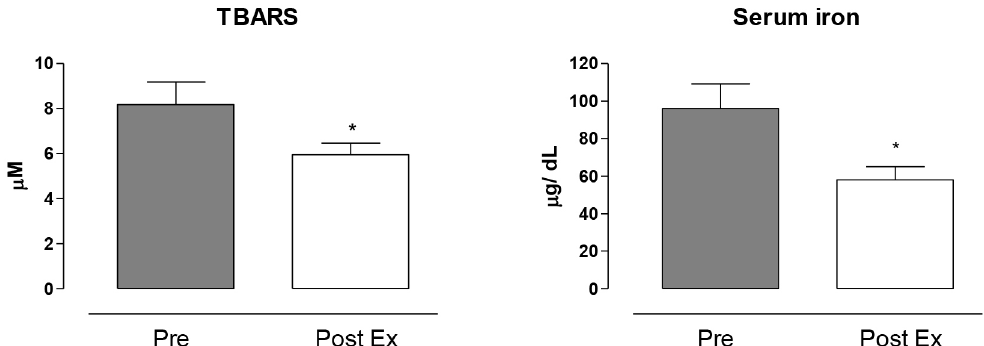
Figure 1. Plasma MDA concentration and serum iron level at baseline (filled columns) and after twenty-four weeks of moderate-intensity physical exercise (open columns) in older women. Paired t- test , data are mean ± S.E.M, n = 11. * Different from Pre.